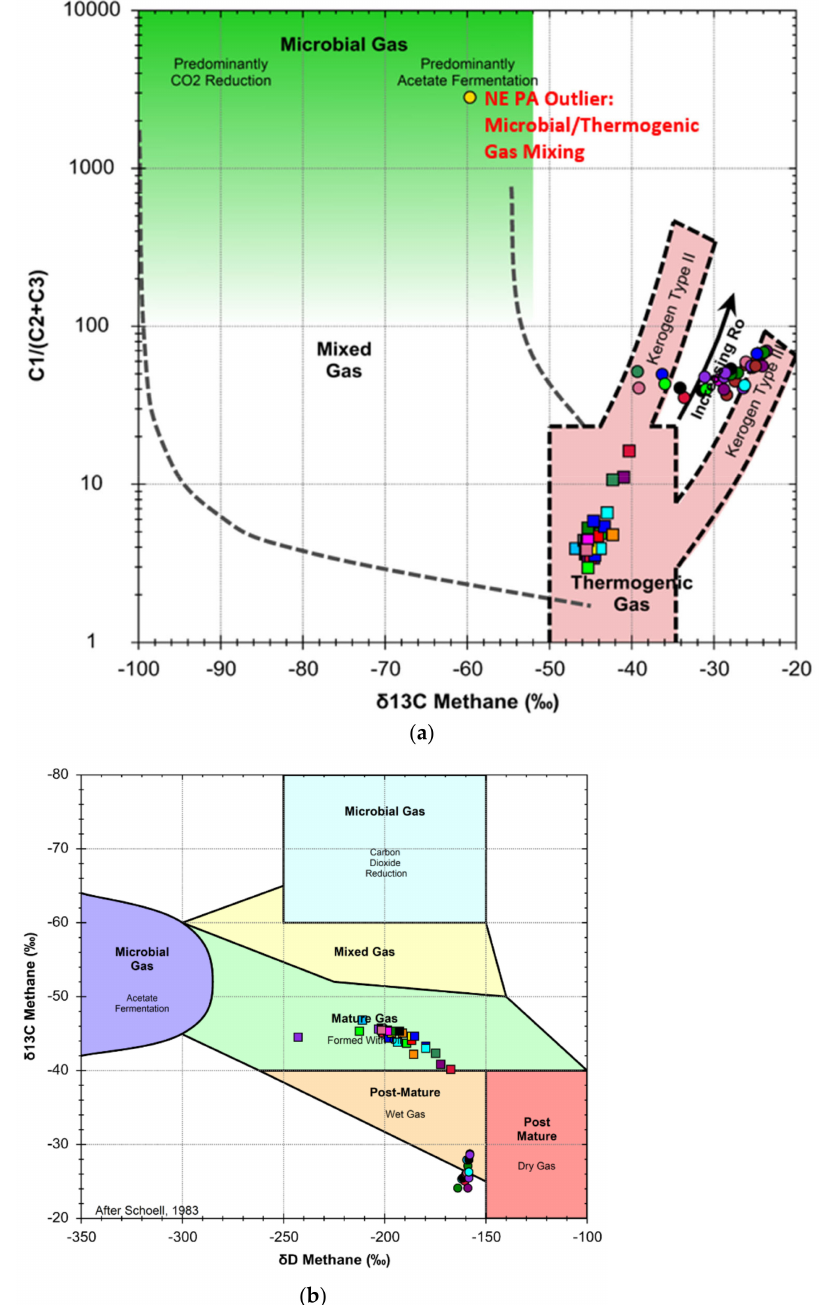
Figure 6. ( a ) : Methane δ 13 C versus C 1 /(C 2 /C 3 ) for wet (squares) and dry (circles) Marcellus Forma- tion produced gases in the Appalachian basin (after Bernard et al. [35]). The different colors represent the various gas samples listed in Table 1 ( b ) Schoell [36] plot of methane δ D versus δ 13 C for the Marcellus produced gases in the Appalachian